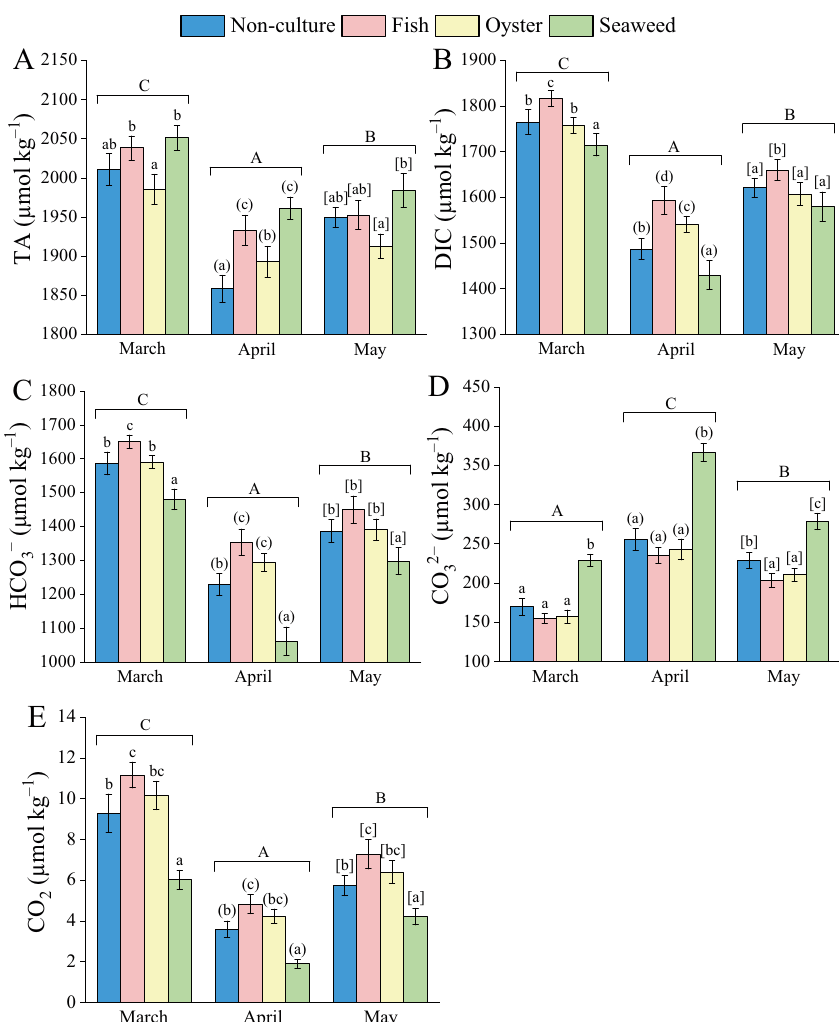
Fig. 4. Variations of the carbonate system parameters (A) total alkalinity (TA), (B) dis- solved inorganic carbon (DIC), (C) bicarbonate (HCO 3− ), (D) carbonate (CO 32− ) and (E) CO 2 in different areas of Shen’ao Bay from March to May 2016. Different lower- case letters without, in round and in square brackets above the columns represent statistically different results in March, April and May, respectively. Different upper- case letters above the columns represent statistically different results among areas in March, April and May. Error bars show